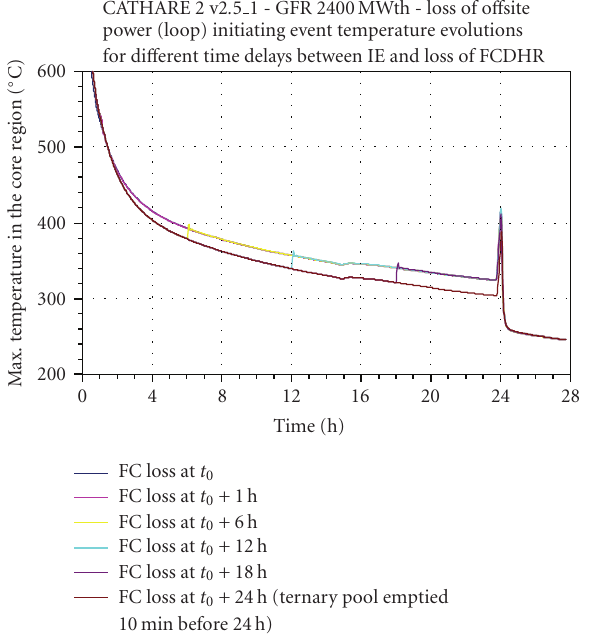
Figure 7: Influence of the time delay before NC actuation on the core temperatures evolutions (1 DHR loop